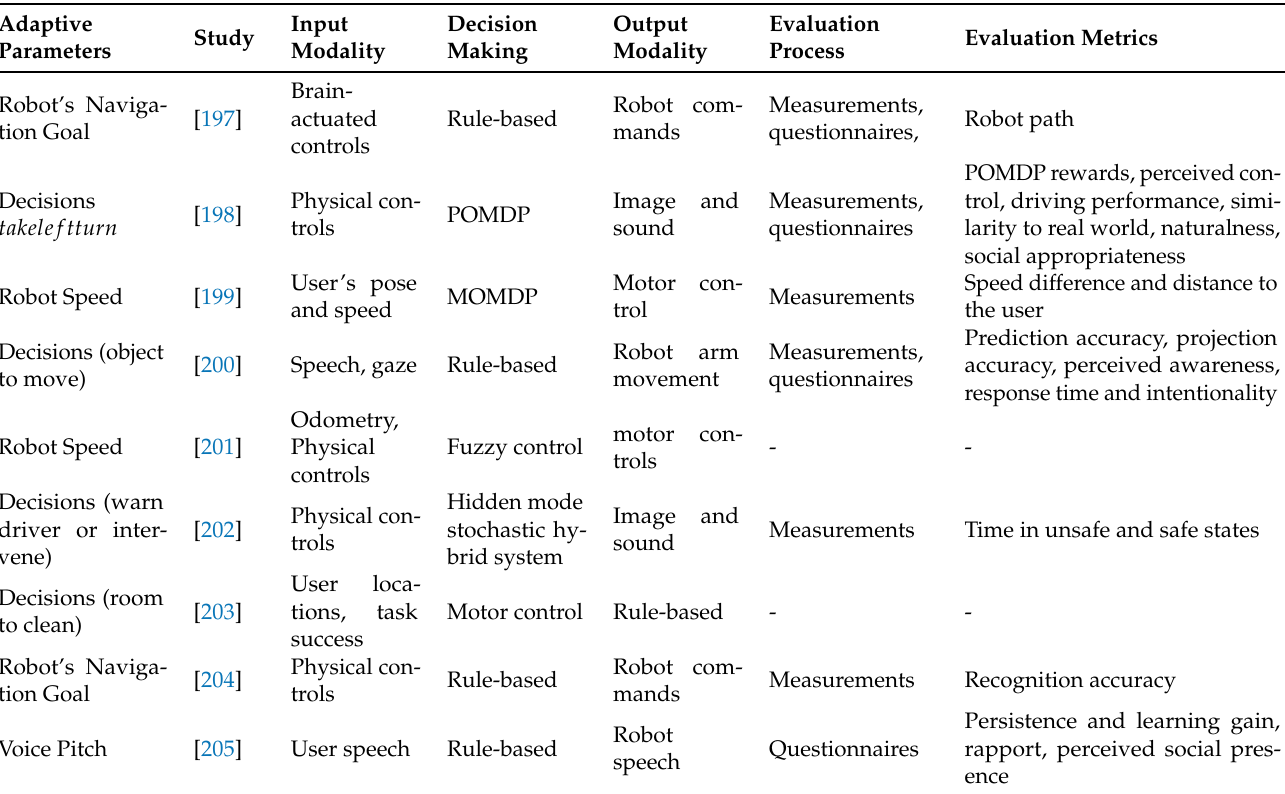
Table 7. Adaptive parameters, input modalities, framework of decision, output modalities, and social robot evaluation with no user